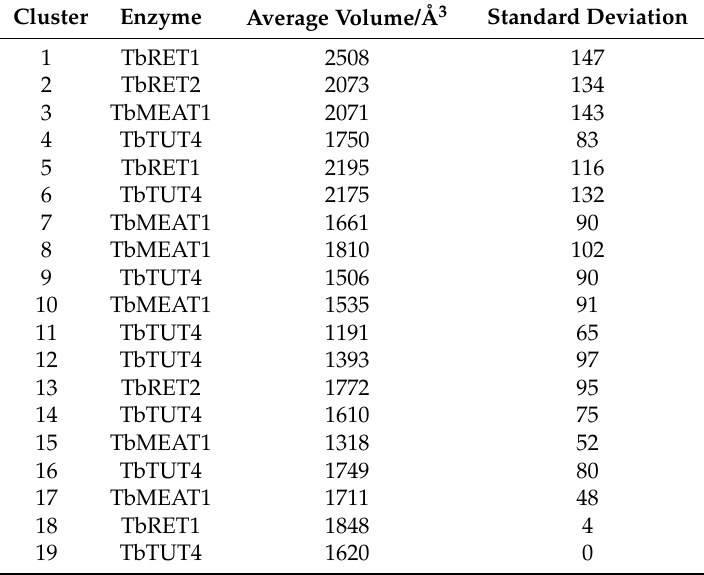
Table 3. The average pocket volume calculated for each cluster. Each cluster was found to contain only one enzyme listed in the second column, suggesting that the pocket volume and shape is distinct for each TUTase. Cluster Enzyme Average Volume/Å 3 1 TbRET1 2508